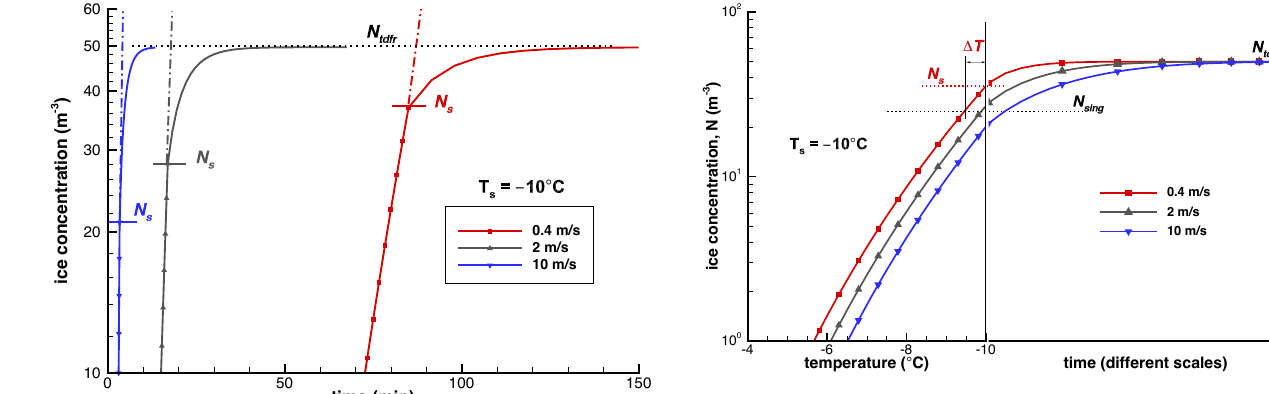
Figure 2. The same data as in Fig. 1 displayed as a function of tem- perature during the lifting of the parcel and as a function of time after that. Timescales differ for the three cases. N s and (cid:49)T are in- dicated for 0.4ms − 1 updraft velocity. (cid:49)T is defined in Eq. (5) with w = 0 . 15 ◦ Cmin − 1 for this case. N sing is the ice concentration from Eq. (3) for − 10 ◦ C using the singular